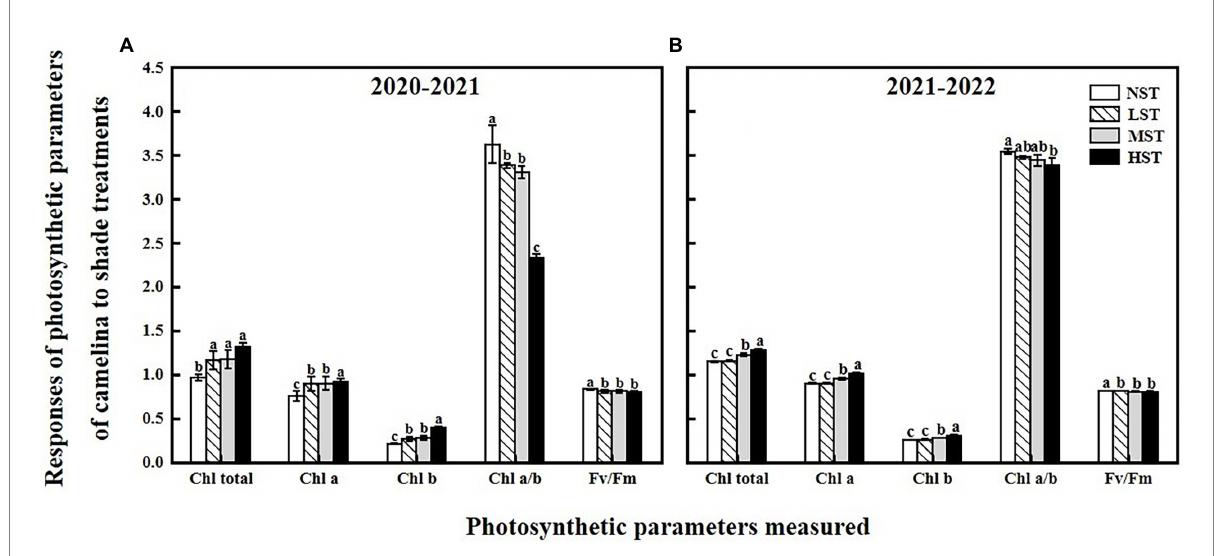
FIGURE 1 Responses of photosynthetic parameters, including the total chlorophyll content (mg g − 1 ), chlorophyll a (mg g − 1 ), chlorophyll b (mg g − 1 ), chlorophyll a / b , and F v /F m of camelina across the 16 genotypes to three different artificial shade levels (15%-LST, 25%-MST, and 50%-HST reduction in natural light intensity, respectively) in 2020–2021 (A) and 2021–2022 (B) . Individual values are means of each parameter measured across the 16 camelina